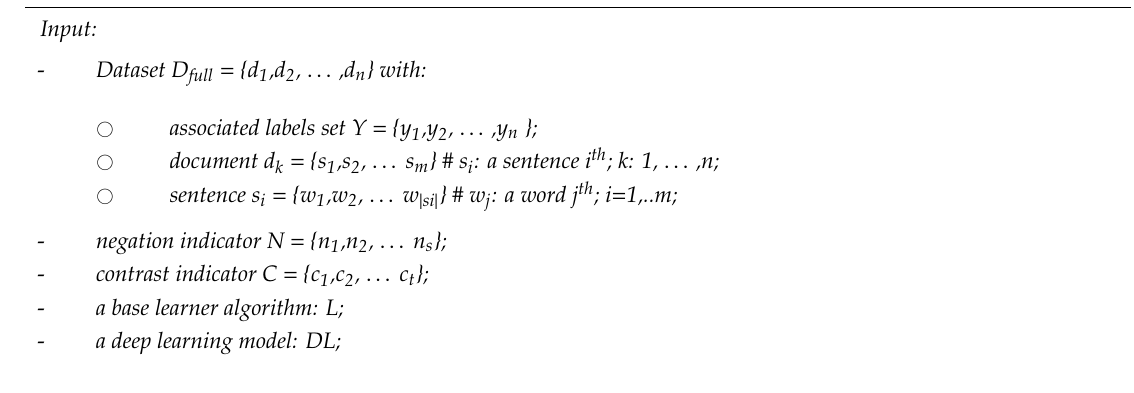
Algorithm 1 . Algorithm of classifier ensemble model